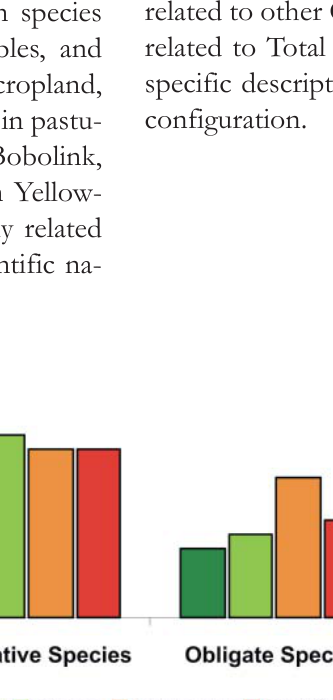
Figure 2. Summary of changes ( Δ trend) in national Breeding Bird Survey (BBS) trends following the start of the Conservation Reserve Program (CRP) for 28 obligate and 46 facultative grassland species in the conterminous Uni- ted